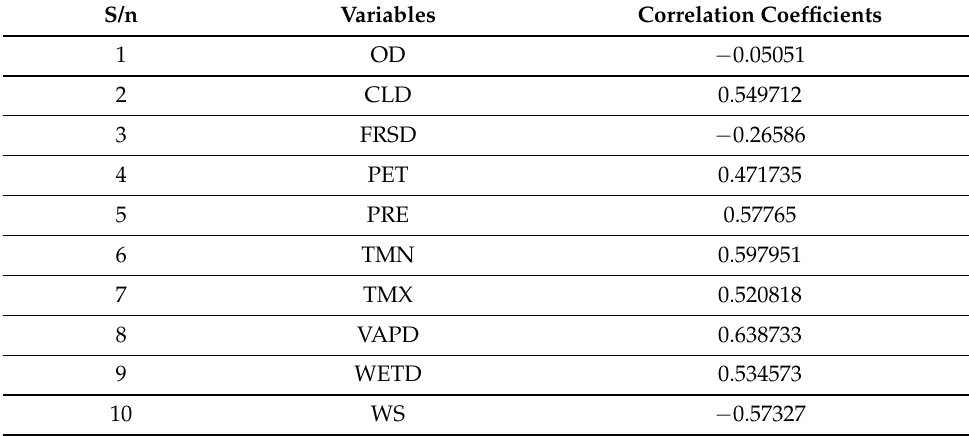
Table 4. Pearson correlation analysis